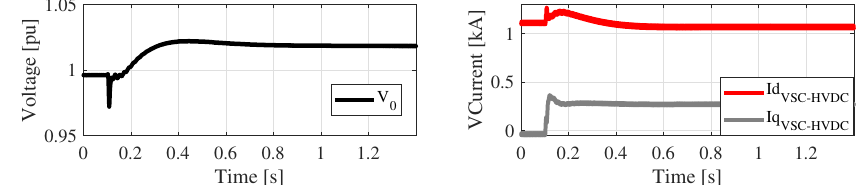
Figure 18. Initial reference of VSC2 voltage ( left ) and VSC2 currents ( right ) when the offshore AC grid becomes weaker.